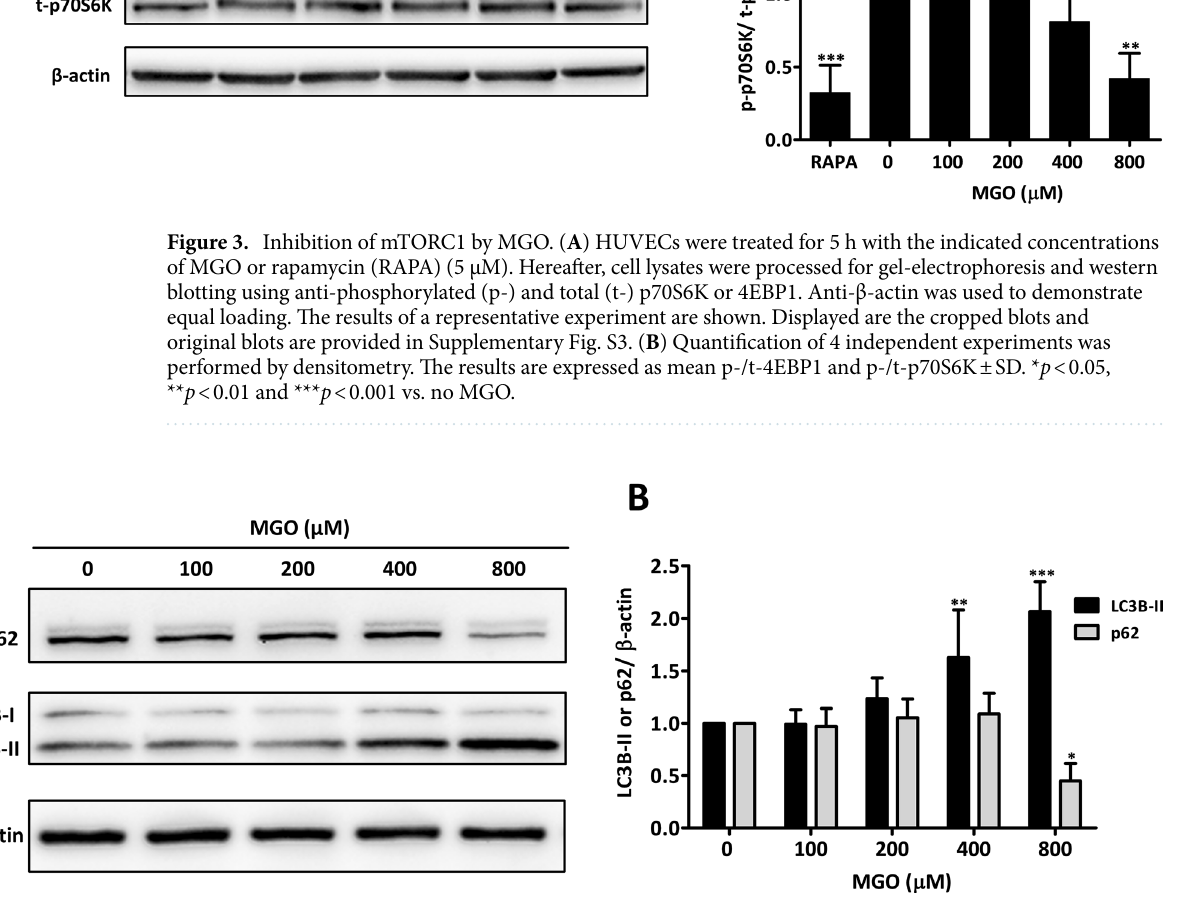
likely cause DNA damage as evidenced by TUNEL and γ-H2AX expression (Fig. 1C), which is generally increased under genotoxic conditions 25 . Our data are compatible with the findings of Thornalley et al . 26 demonstrating